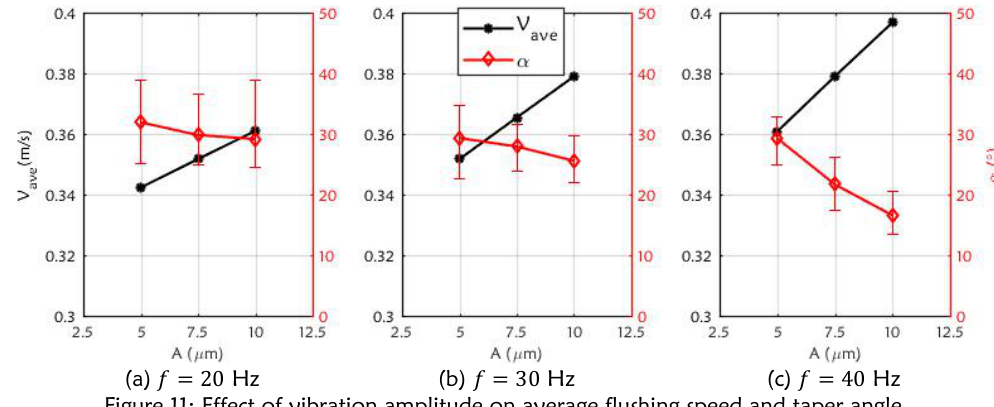
Figure 11: Effect of vibration amplitude on average flushing speed and taper angle